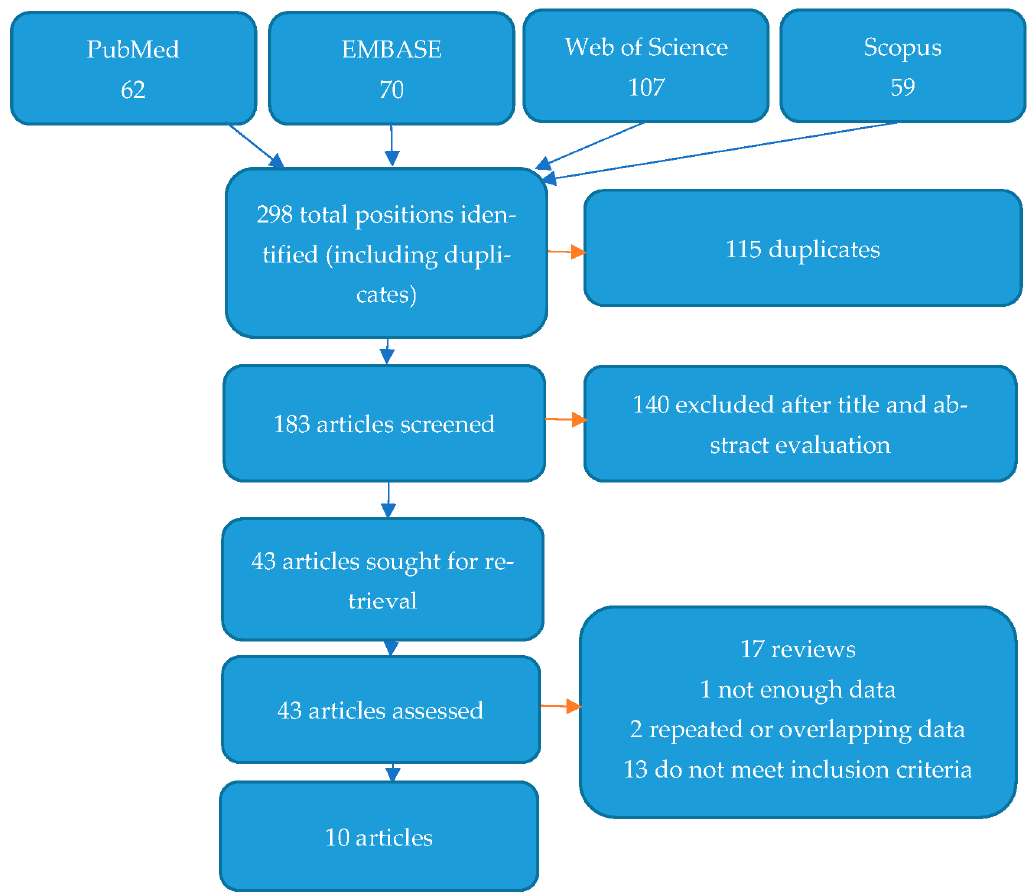
Figure 3. Flow diagram demonstrating the search and selection process for articles.